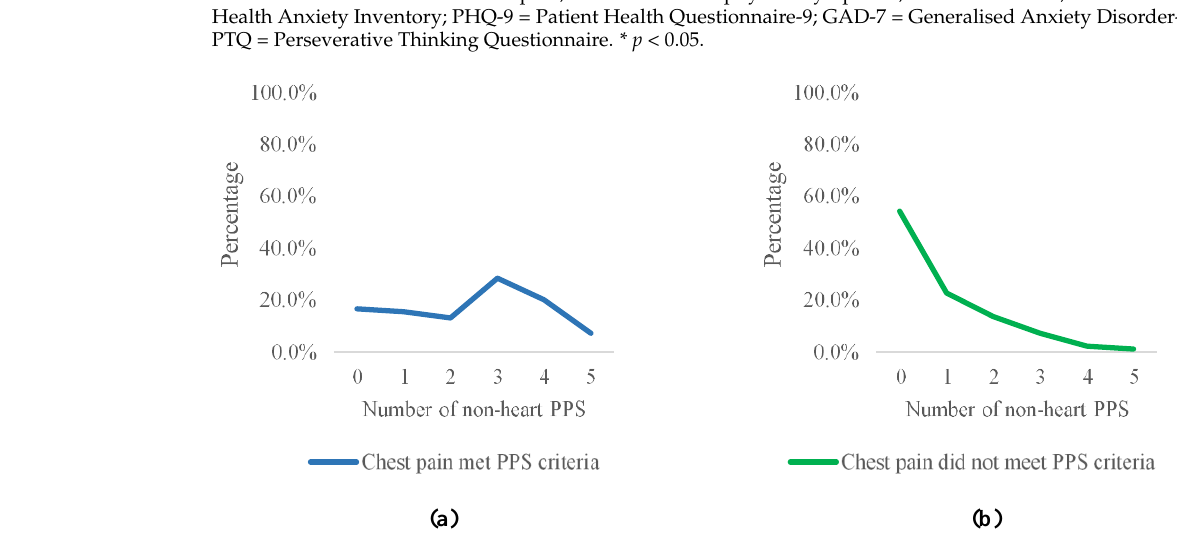
Figure 2. ( a ) Percentage of participants whose chest pain symptoms met PPS criteria and who met criteria for none, one or more non-heart-related PPS. ( b ) Percentage of participants whose chest pain did not meet PPS criteria and who met criteria for none, one or more non-heart-related PPS.